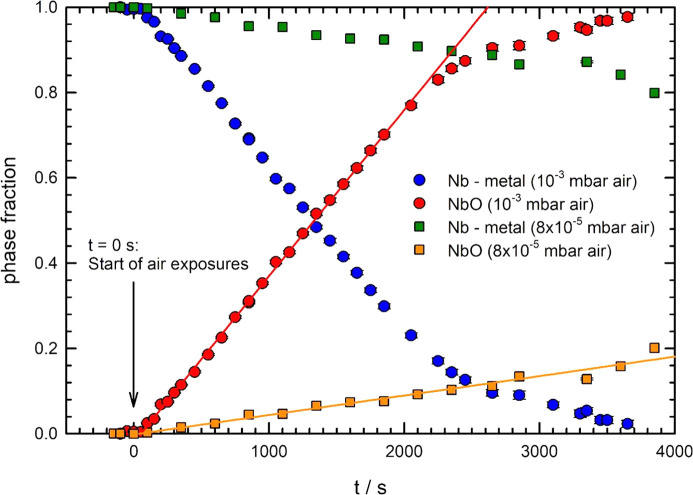
Concentration of Nb-metal (blue circles, green squares) and NbO (red circles, brown squares) as determined from the evaluation of time-resolved EXAFS data of 8 µm-thick Nb foils as a function of time and two different air pressures during oxidation at 900°C. The full coloured lines correspond to linear oxidation kinetics with time for both treatments.